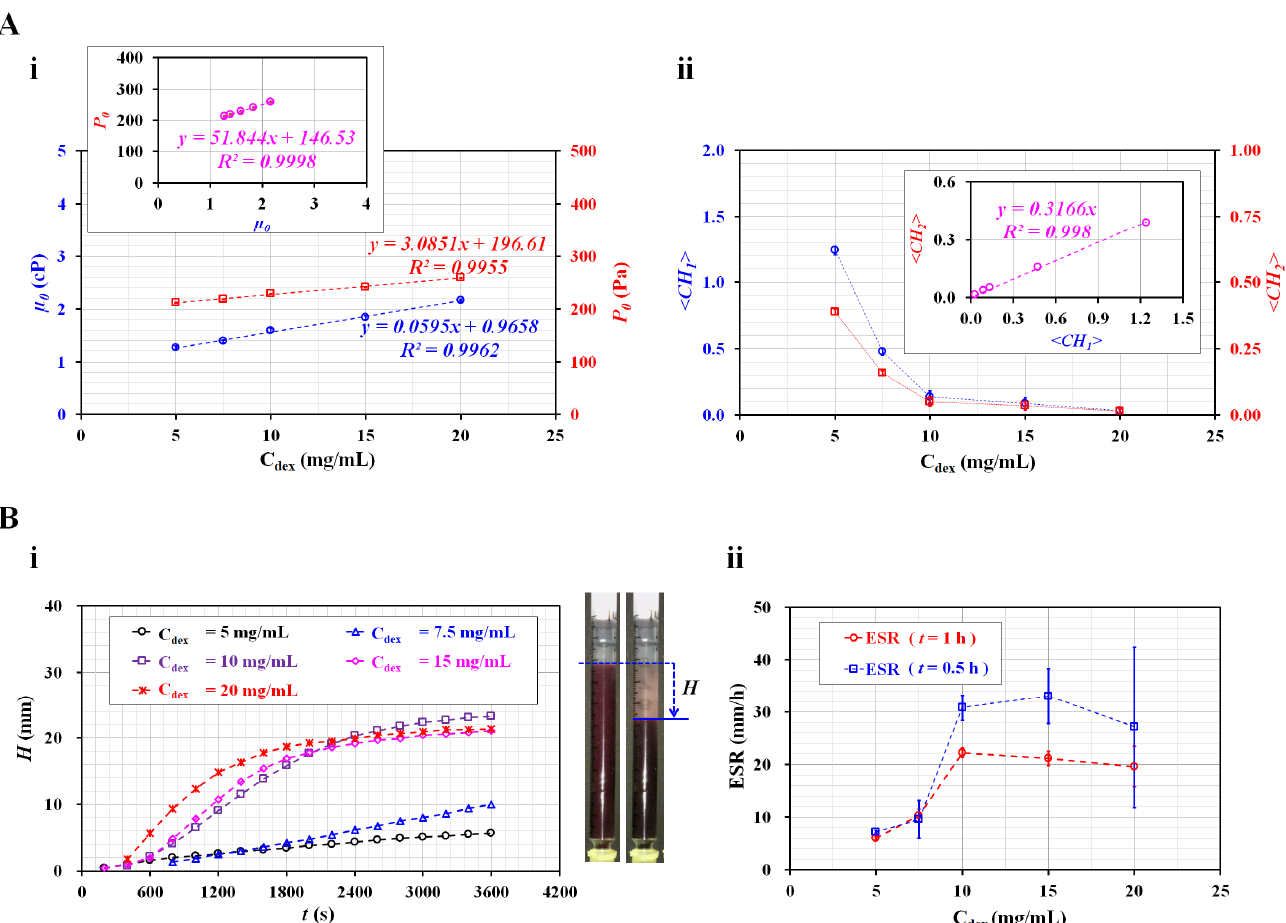
Figure 6. Quantitative comparison between the present and conventional ESR methods for RBC aggregation-enhanced bloods. ( A ) Variations in four factors (i.e., µ 0 , P 0 , < CH 1 >, and < CH 2 >) obtained using the present method. ( A - i ) Variations in viscosity ( µ 0 ) and junction pressure ( P 0 ) of the diluent with respect to C dex . ( A - ii ) Variations in < CH 1 > and < CH 2 > with respect to C dex . ( B ) Quantitative measurement of ESR using a conventional ESR method. ( B - i ) Temporal variations in RBC sedimen- tation ( H ) with respect to C dex . Right side panel showed snapshots of the RBC sedimentation of a blood sample (C dex = 20 mg/mL) at t = 0 and 1 h. ( B - ii ) Variations in ESR obtained at t = 0.5 h and 1 h with respect to C dex